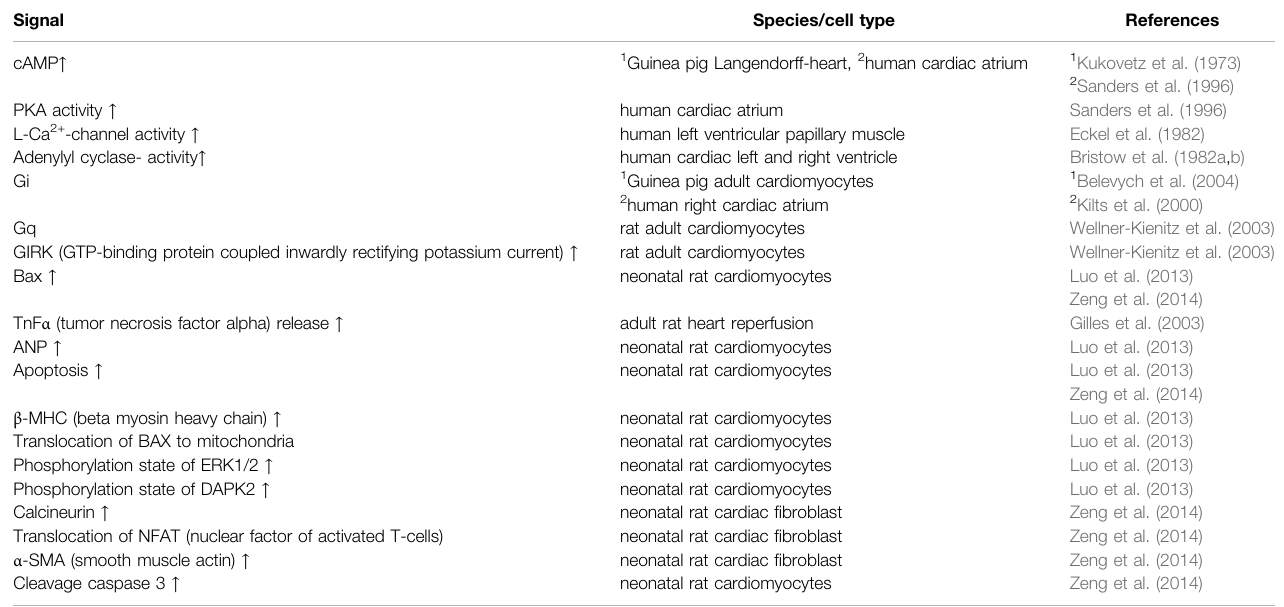
TABLE 6 | Signal transduction of H 2 -histamine